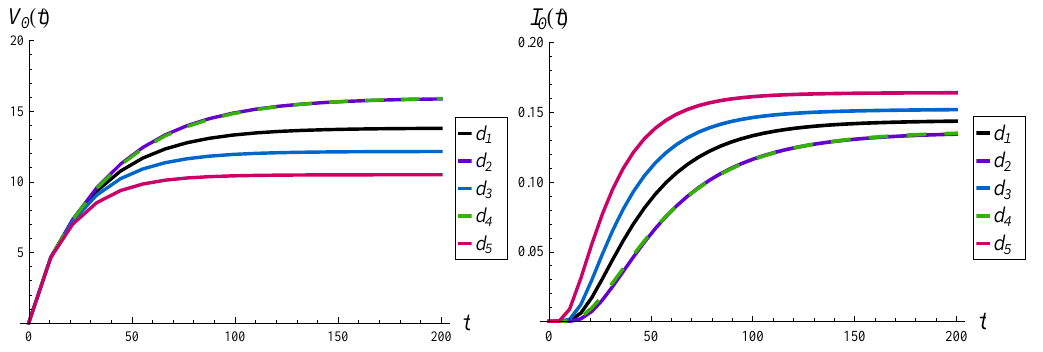
Figure 2. Average waiting time (on the left) and intensity of losses (on the right) vs. time, for different functions d ( k ) .